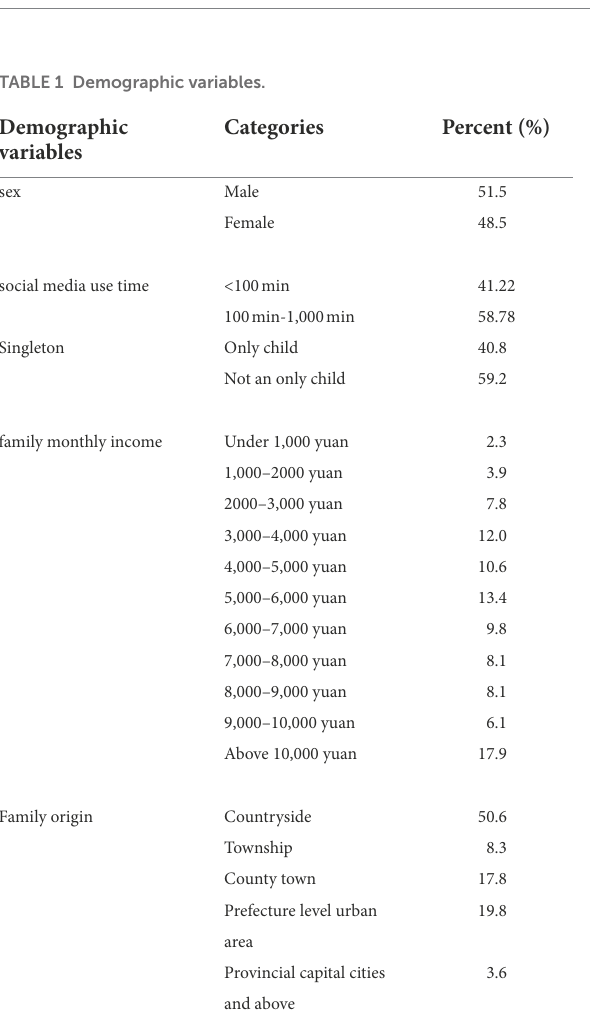
FIGURE 1 The model of the current study.